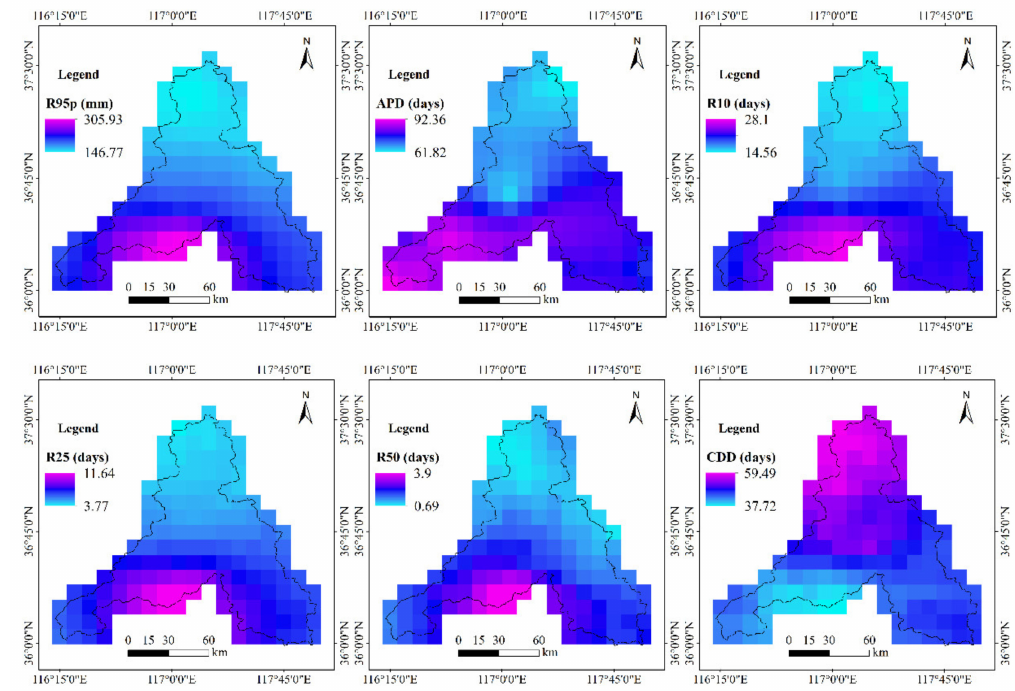
Figure 7. Spatial distribution of precipitation indices in Jinan City during the period of 1979–2017.